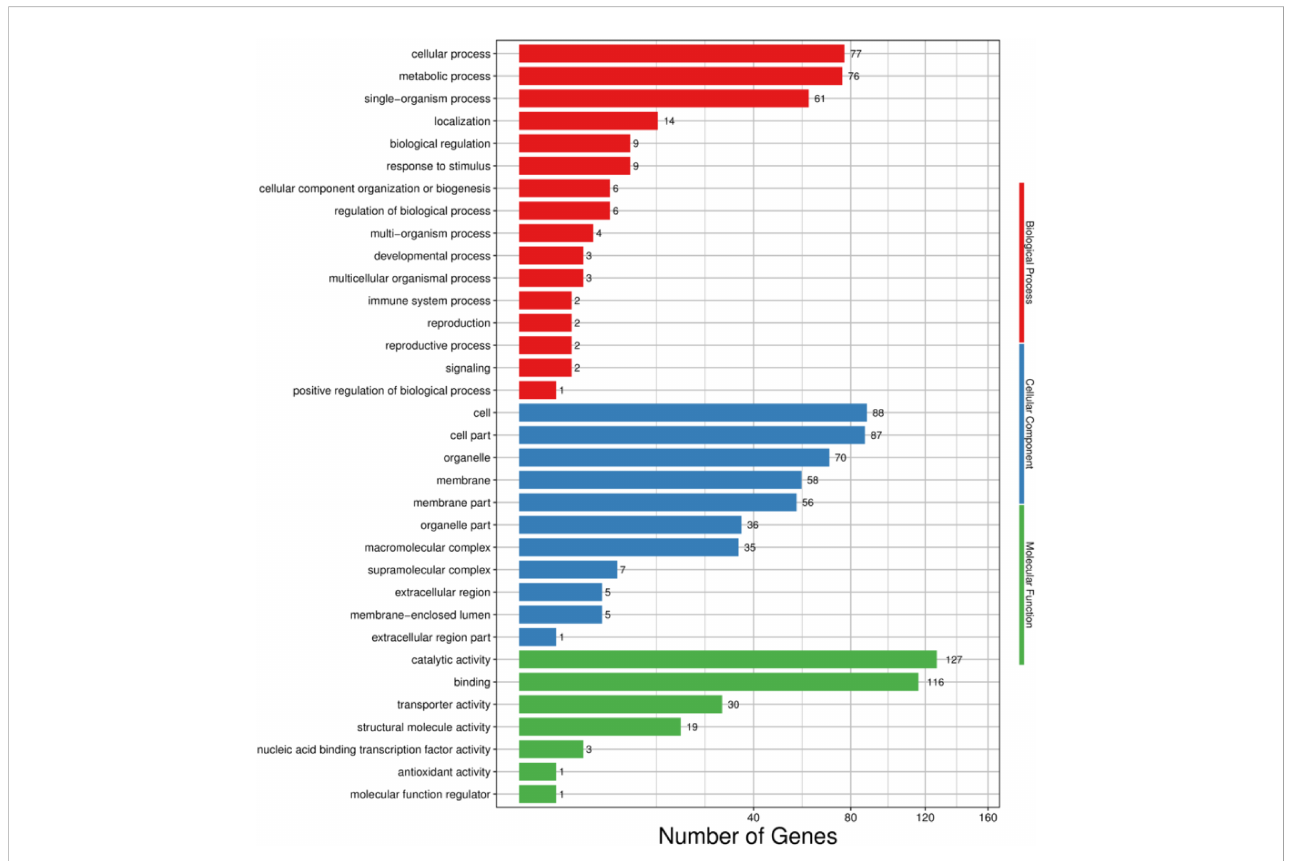
FIGURE 6 GO functional classifcation of DEGs in H. cunea . Red, blue and green represent biological process, cellular component and molecular function. The x- axis represents the number of transcripts; the y-axis represents GO